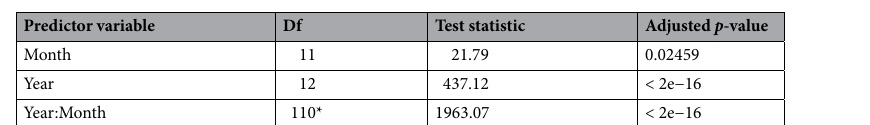
Table 1. Assessing the likelihood of an effect on the number of Chagos songs per day at site DGN (n = 3917 days). Test statistics and p -values obtained via type 1 ANOVA likelihood ratio tests from a negative binomial, generalized additive model. p -values have also been adjusted to account for multiple hypothesis testing using the Holm adjustment 45 . *Degrees of freedom are smaller than expected due to some years (n = 4) having missing